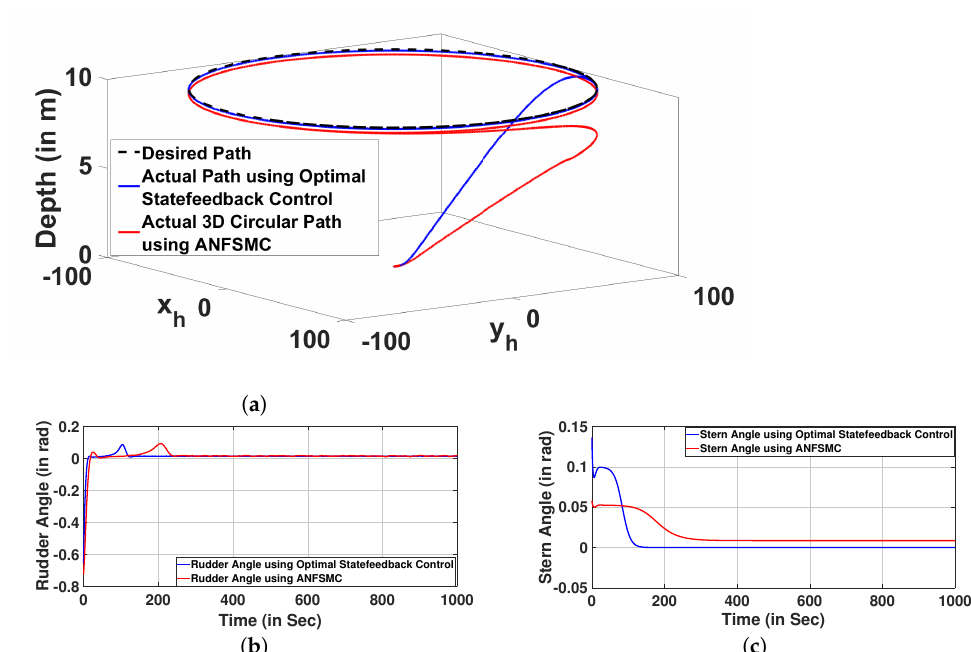
Figure 9. 3D Path Following for Circular Path for ± 10% Uncertainty. ( a ) 3D Plane Path Following, ( b ) Rudder Angle, ( c ) Stern